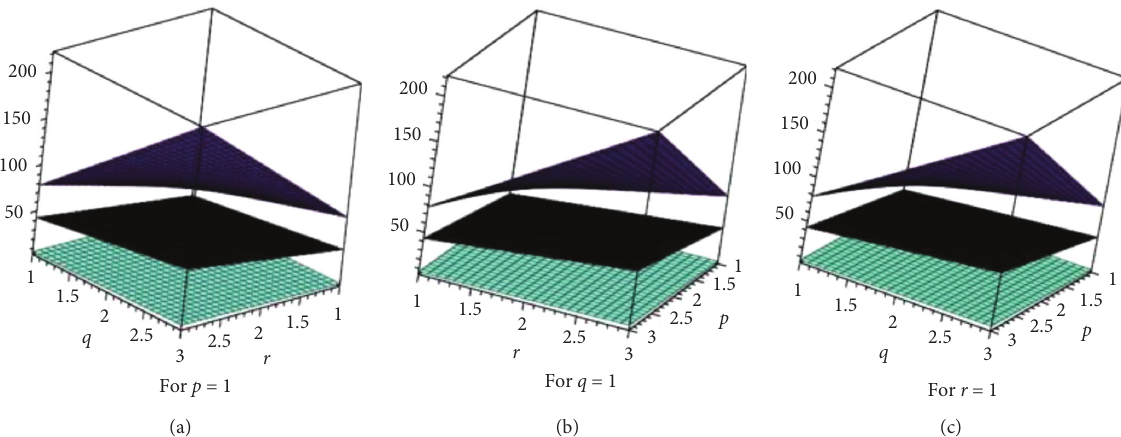
Figure 12: Comparison of IRA , IRB, and IRDIF for crystallographic structure of titanium difluoride T